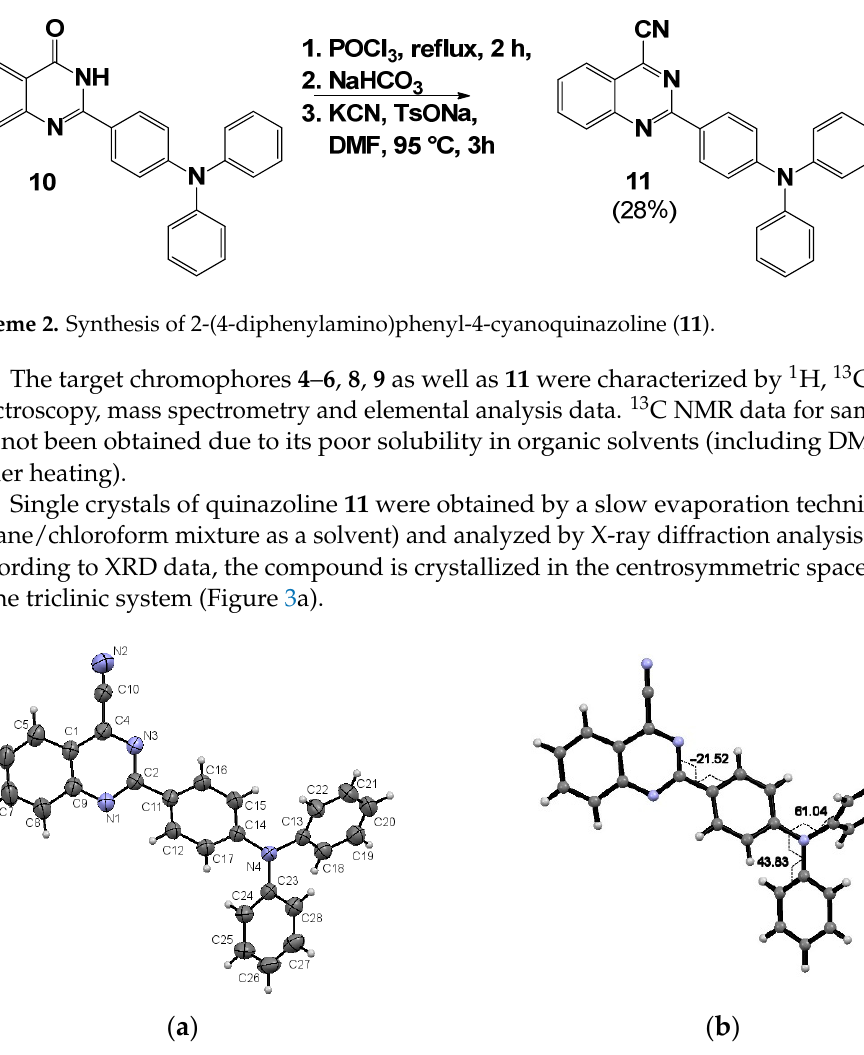
Figure 3. ( a ) Molecular structure of 11 in the thermal ellipsoids of 50% probability; ( b ) Selected tor- sion angles of compound 11 .